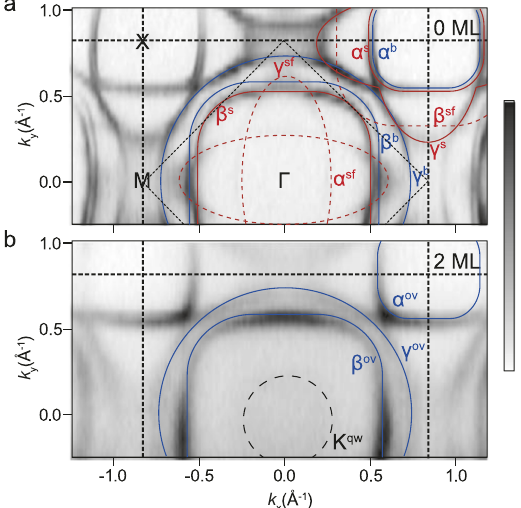
Fig. 1 Fermi surface (FS) maps of Sr 2 RuO 4 . a Fresh Sr 2 RuO 4 and b Sr 2 RuO 4 covered in two monolayers (MLs) of K. The black thick (thin) dashed lines mark the Brillouin zone of the bulk (surface) Sr 2 RuO 4 without (with) octahedral rotation. RuO 6 octahedra on the ffiffiffi p ffiffiffi p ´ 2 2 surface rotate, resulting in a reconstructed surface that causes replica FSs to appear. Superscripts b, s, sf, and ov denote bulk, surface, surface folding, and overlap, respectively. The blue (red) guidelines indicate the bulk (surface) bands. K qw indicates a K circular quantum well state (Supplementary Fig. 4).